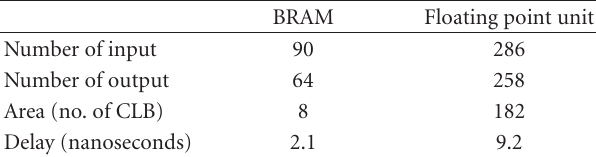
Table 1: Statistic of the coarse-grained blocks used.